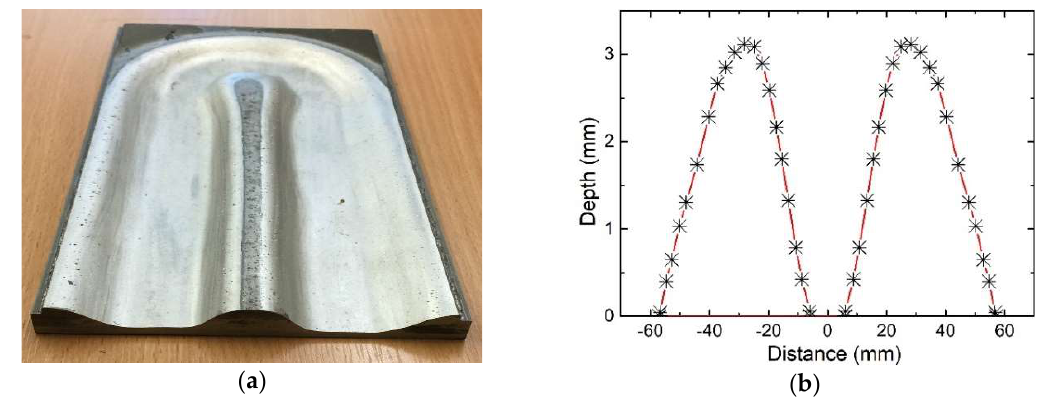
Figure 27. The sputtering erosion track of the target (trackyield).